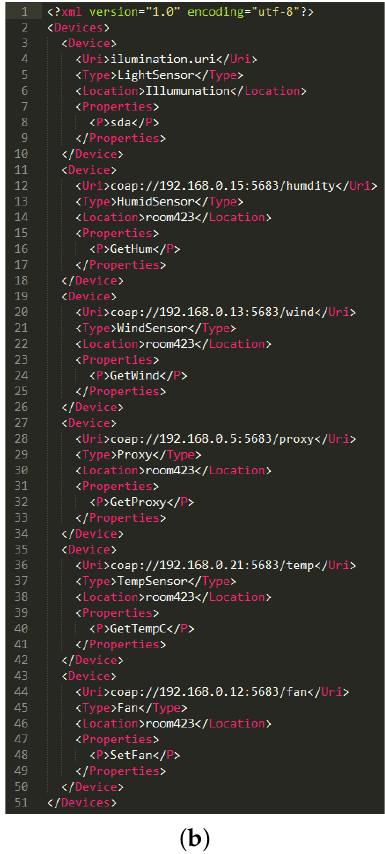
Figure 9. Virtual device representation. ( a ) Virtual device web interface; ( b ) XML representation.